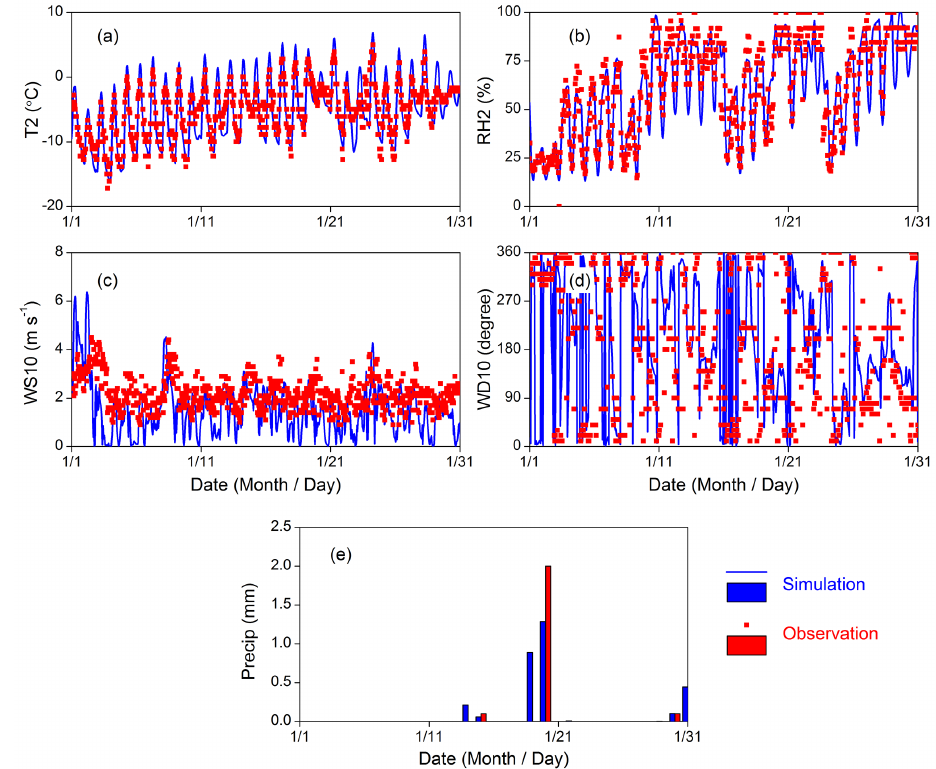
Figure 3. Observed and simulated meteorological variables at THU site: (a) hourly T2; (b) hourly RH2; (c) hourly WS10; (d) hourly WD10; (e) daily